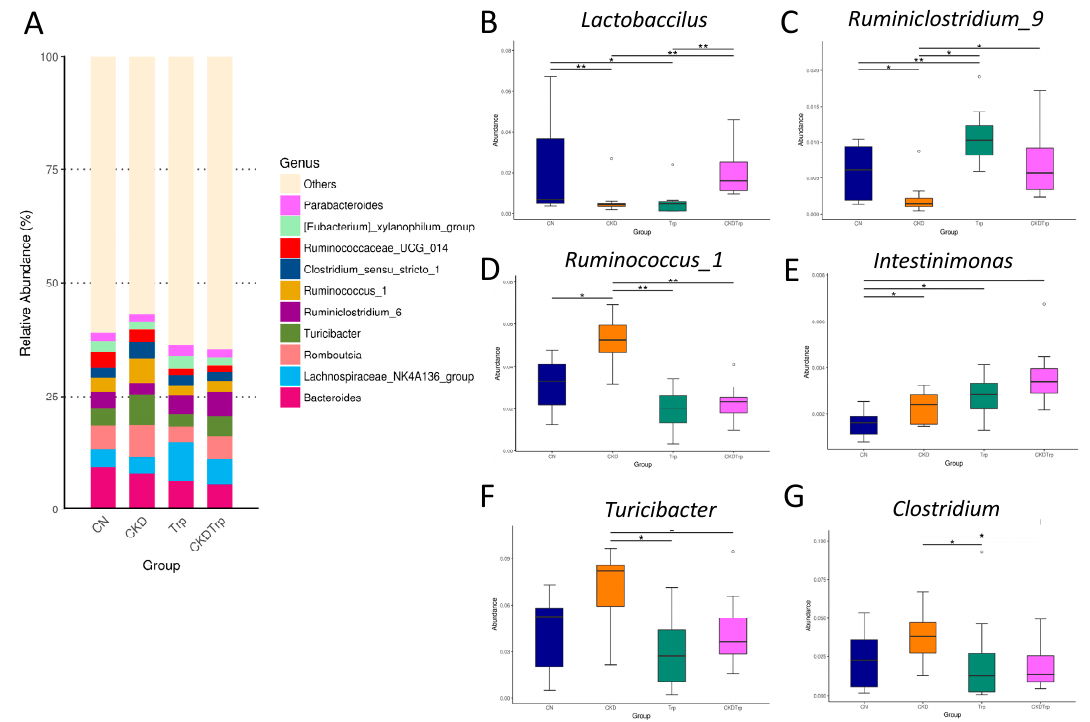
Figure 5. E ff ects of maternal adenine-induced chronic kidney disease (CKD) and tryptophan supplementation (Trp) on the gut microbiota at the genus level in 12-week-old o ff spring. ( A ) Relative abundance of top 10 genera of the gut microbiota among the four groups. Relative abundances of the genus ( B ) Lactobacillus, ( C ) Ruminiclostridium_9 , ( D ) Ruminococcus_1 , ( E ) Intestinimonas , ( F ) Turicibacter, and ( G ) Clostridium . * p < 0.05. ** p < 0.01. *** p < 0.001.